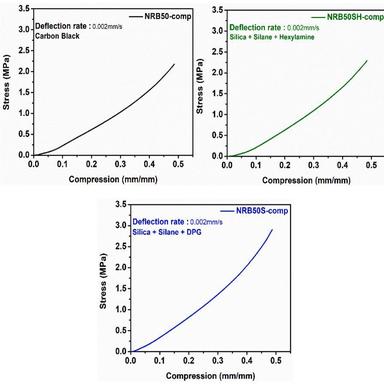
Stress-strain relationship obtained from the monotonic compression test to a compressive strain equal to 50%.